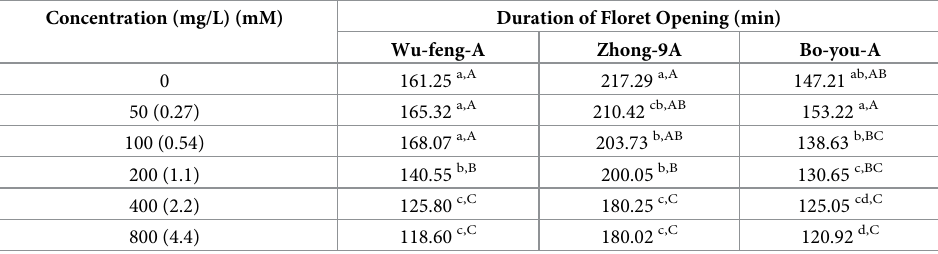
Table 5. NAA regulation of the duration of floret opening in sterile rice.